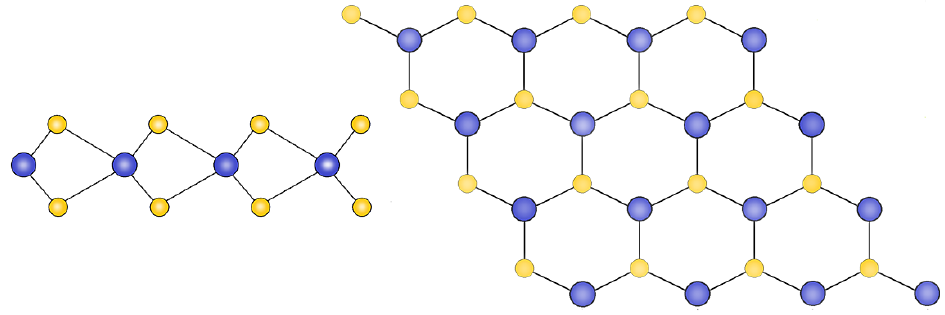
Figure 4. The side and top view of the MoS 2 sheet. Reproduced with permission from [148], Copyright Elsevier, 2011.